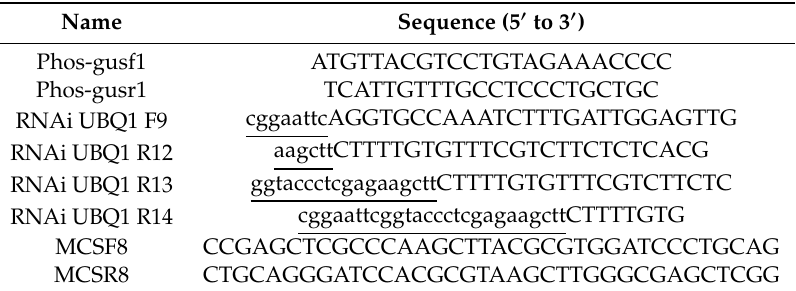
Table 2. List of primers used for construction of the destination vector.